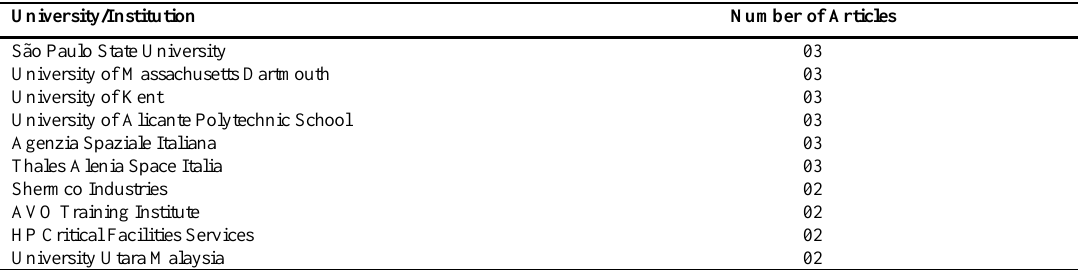
Table 3. Affiliation-wise publications: intellectual capital and operational excellence